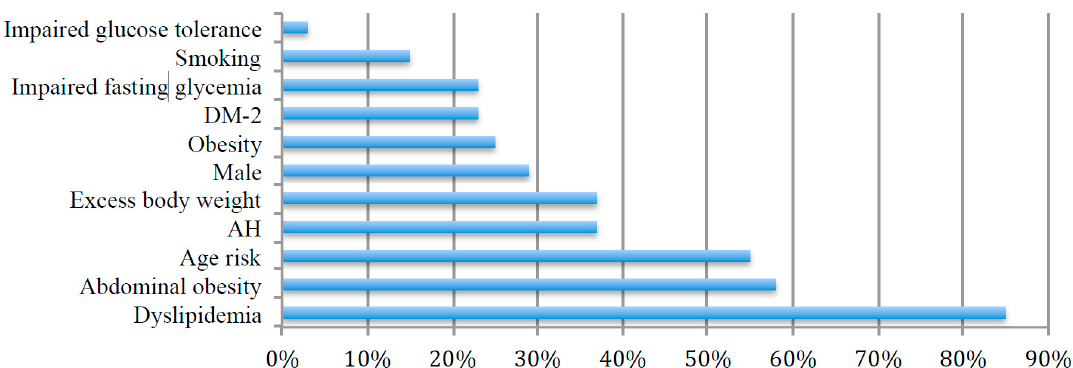
Figure 1. Prevalence of cardiovascular risk factors in participants. DM-2—diabetes mellitus type 2, AH—arterial hypertension.